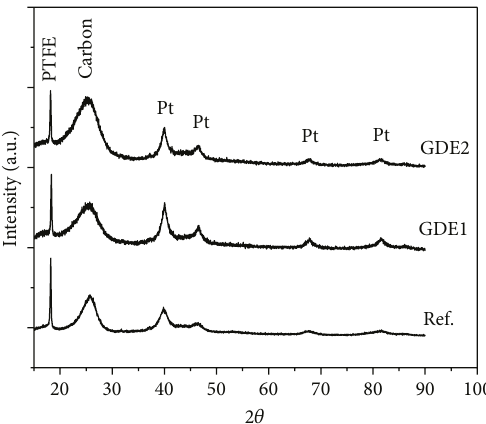
Figure 1: Comparison of the XRD spectra of GDE1, GDE2, and